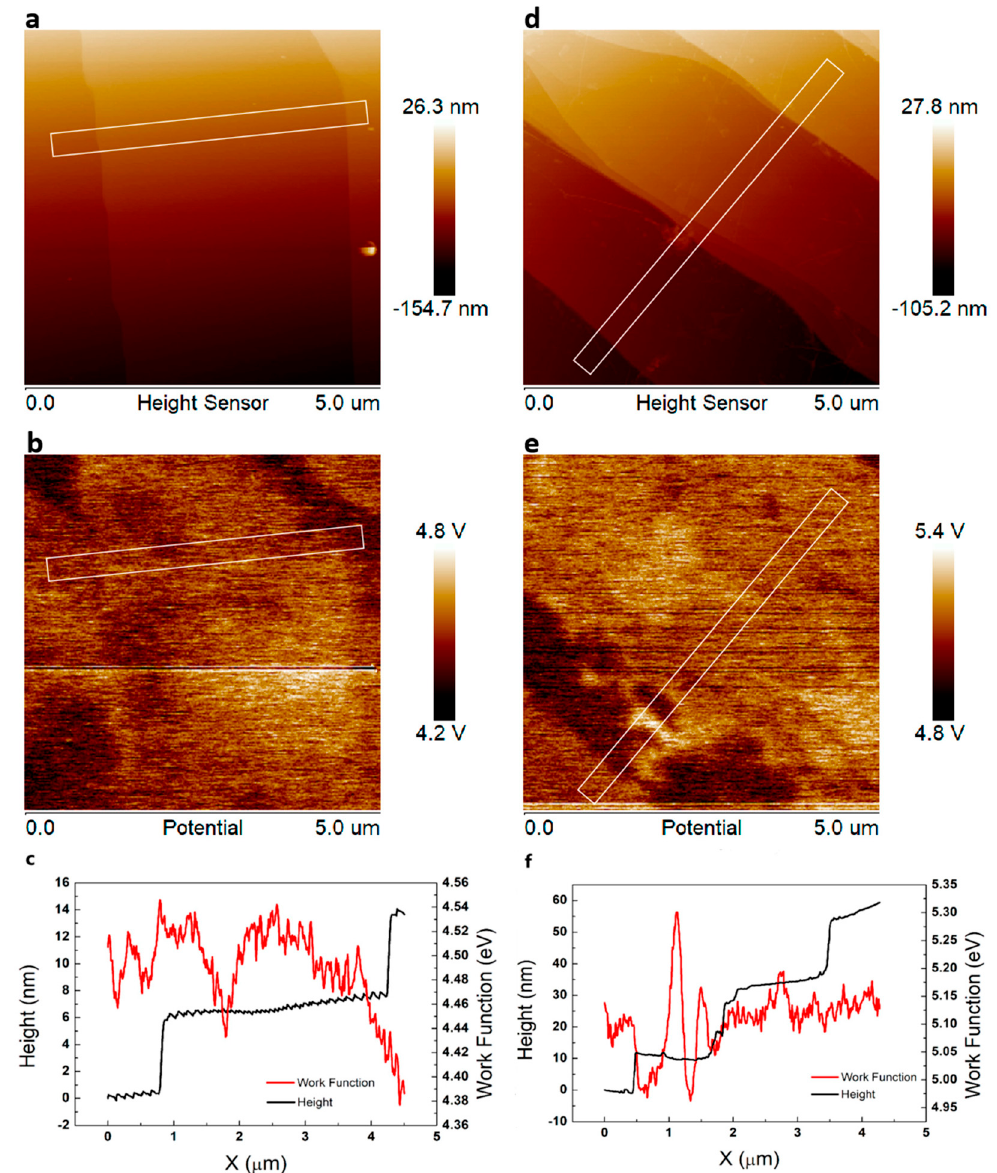
Figure 2. The atomic force microscopy (AFM) image of the epitaxial graphene (EG) sample ( a ) and quasi-free-standing graphene (QFSG) sample ( d ) within a 5 × 5 square micron square. The steps on the surface of both samples are on the order of micrometers with no obvious defects. ( b , e ) are respectively the Kelvin probe force microscope (KPFM) test results of the EG sample and the QFSG sample. And the height distribution and work function distribution of EG sample ( c ) and QFSG sample ( f ) were obtained from the white rectangular area in ( a , b , d , e ). The work function of the EG sample is about 4.50 eV. The work function of the QFSG sample is about 5.15